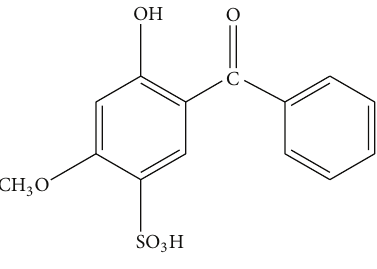
Figure 1: Structure of